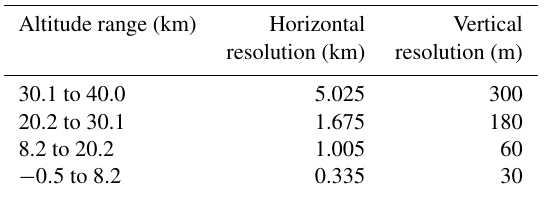
Table 1. Spatial resolution of downlinked data from CALIOP at